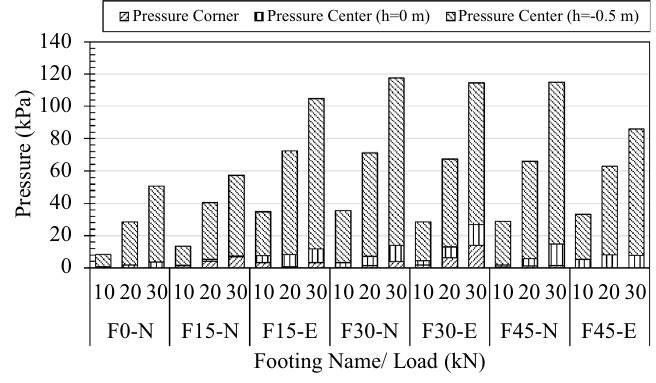
Fig. 14 Pressure cell readings for different folded